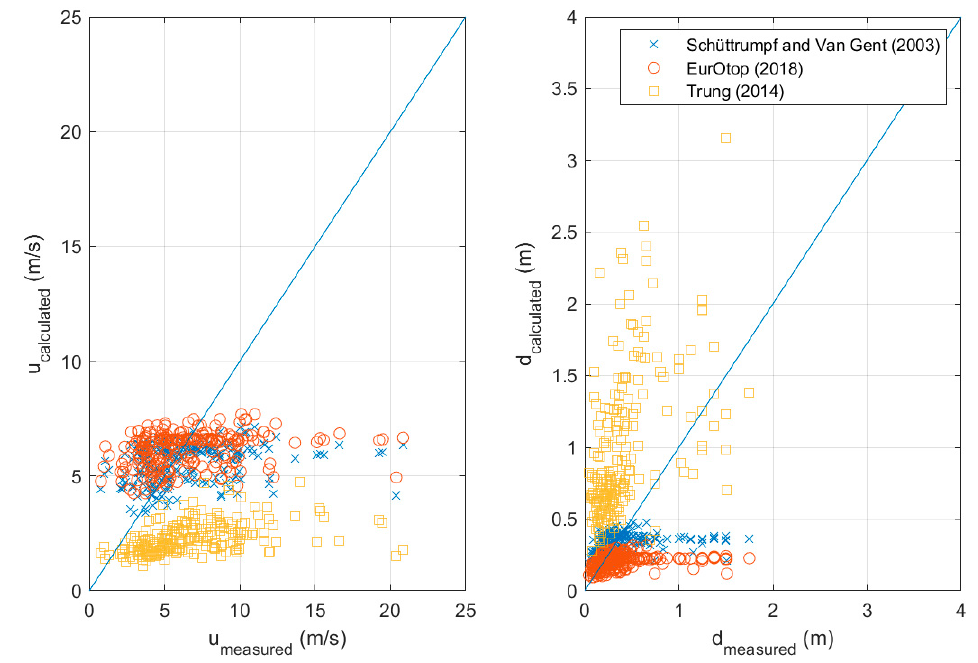
Figure 16. Estimation of overtopping flow depth and velocity employing existing formulas from Schüttrumpf and Van Gent (2003), Trung (2014) and EurOtop (2018).